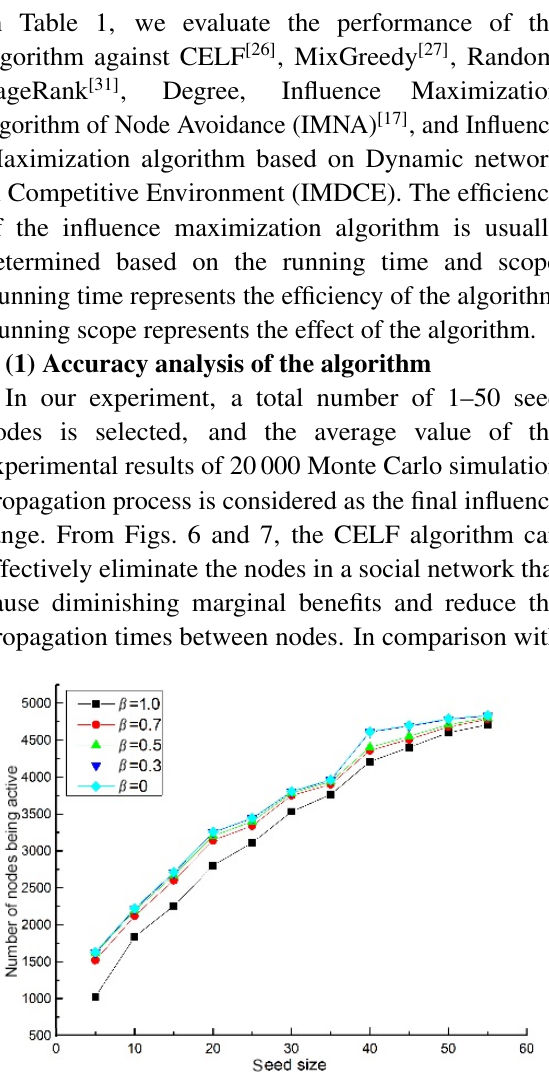
Fig. 4 Node influence range under different parameters.